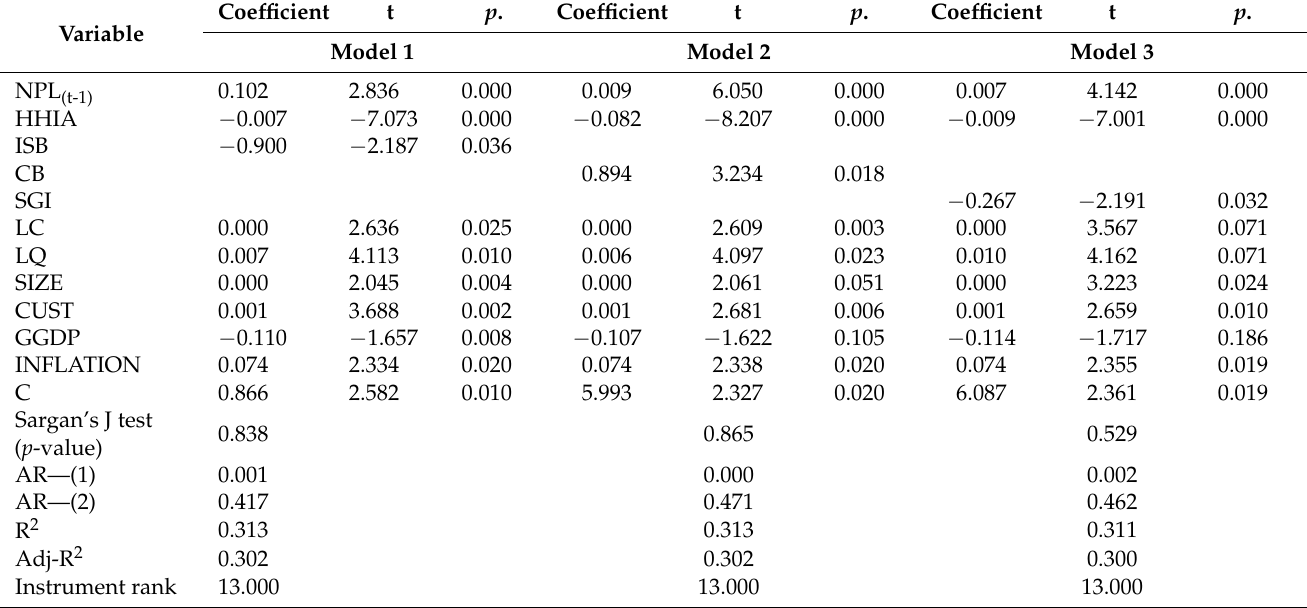
Table 6. Effects of competition (Based on HHIA), loan quality and ownership structure on credit